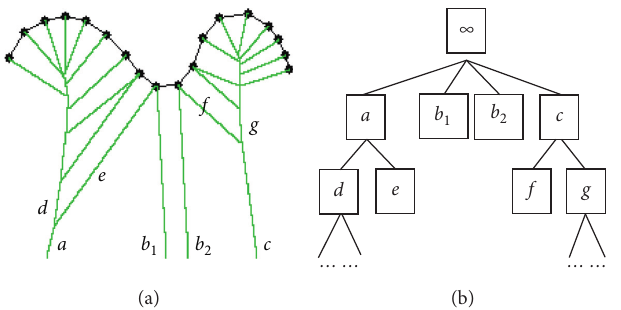
Figure 3: (a) The edges in the lower part of the Voronoi diagram in Figure 2. (b) The 3 top levels of the Voronoi tree.